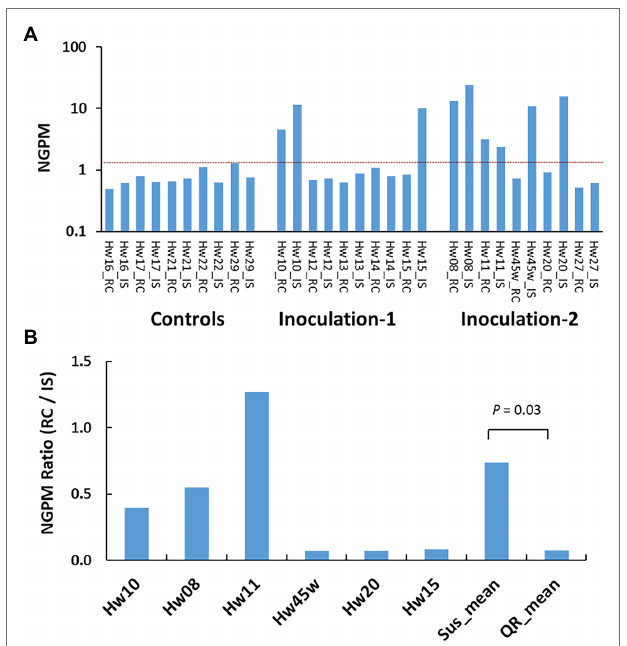
FIGURE 1 | Variations of Heterobasidion occidentale genes expressed in western hemlock tissues. Number of expressed genes detected by RNA-seq were normalized as number of genes per million raw reads (NGPM). (A) Gene detected in 15 individual seedlings, and each seedling was sampled at the inoculation site (IS) and root collar (RC), respectively. Red dash line separate infected samples from non-infected samples based on the NGPM as measured in the controls (seedlings with mock inoculation). (B) Grouping of infected seedlings based on NGPM ratios. Significant difference was detected between susceptible seedlings (Sus) and seedlings with quantitative resistance (QR).